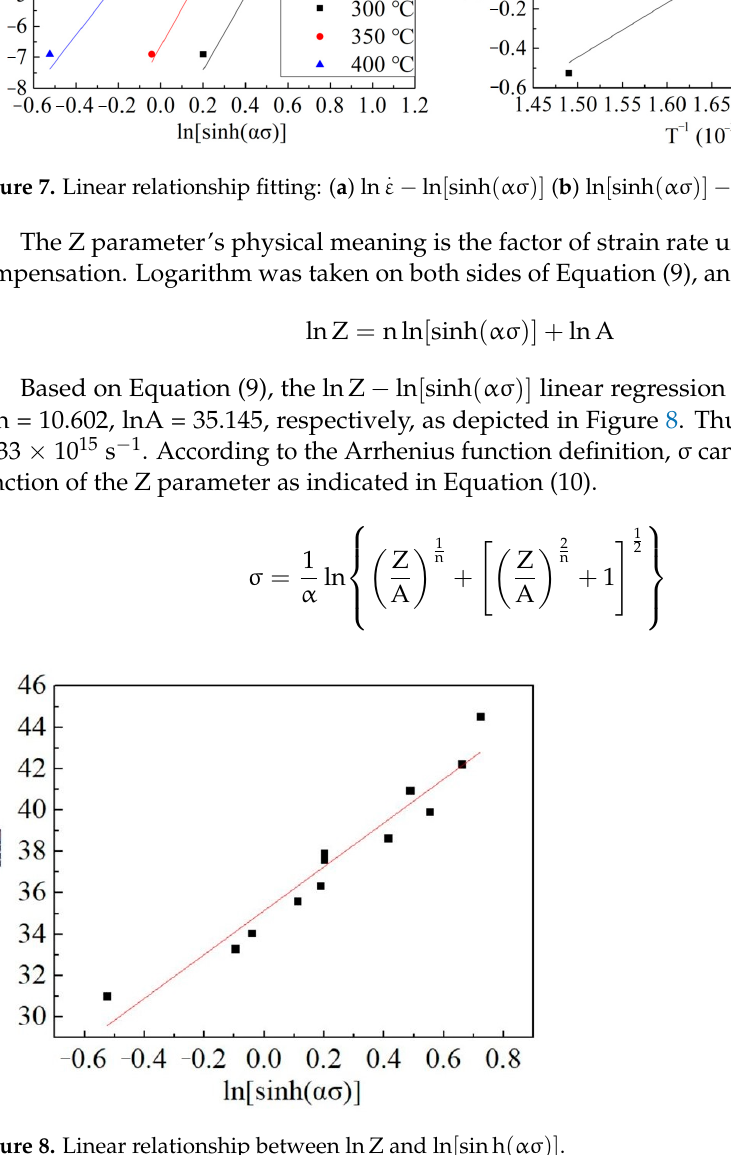
Figure 8. Linear relationship between lnZ and ln [ sinh ( ασ )]